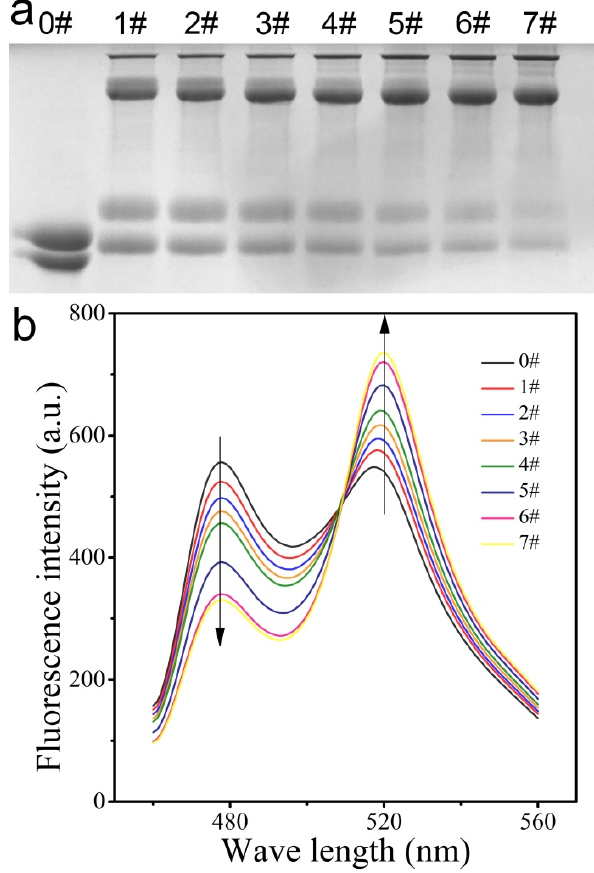
Figure 2. Demonstrations of H 2 O 2 induced homo / hetero dimerization between CFP-Prx and mTrx-YFP and corresponding fluorescence resonance energy transfer (FRET) signal changes. ( a ) SDS-PAGE of CFP-Prx and mTrx-YFP mixtures after reacting with H 2 O 2 , in 0# sample no H 2 O 2 existed, from 1# to 7# sample H 2 O 2 concentration increased gradually. ( b ) Fluorescence spectra of the same sample as indicated in panel ( a ).